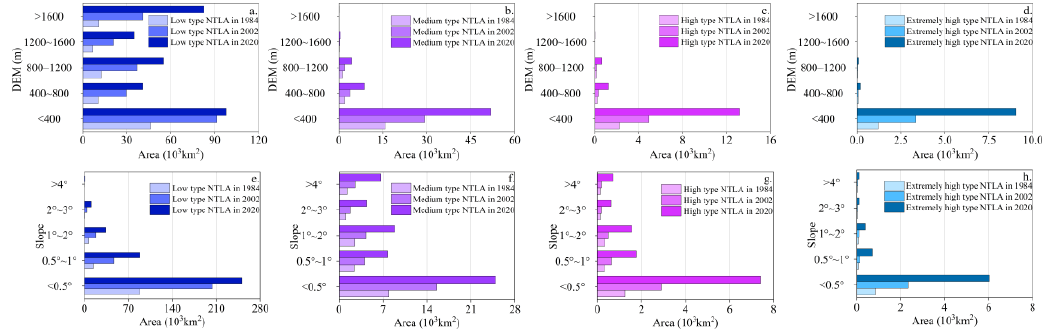
Figure 13. Correlation analysis between the DEM, slope, and different nighttime lighting types in 1984, 2002, and